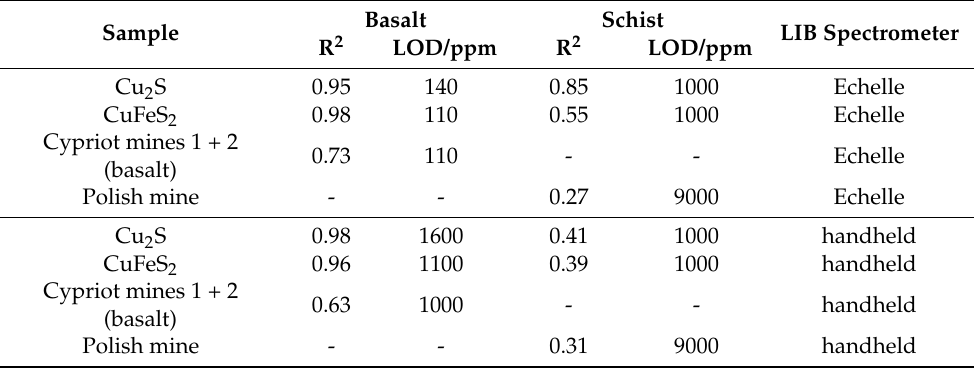
Table 2. Coefficients of determination R 2 and LOD of the univariate regressions of the synthetic samples and the field samples in basalt and schist with the Echelle and handheld spectrometer.